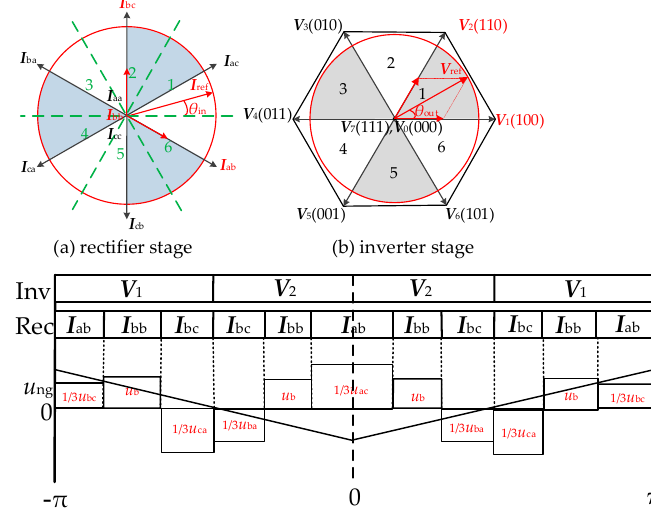
Figure 8. Modulation principle and vector distribution of method 4.